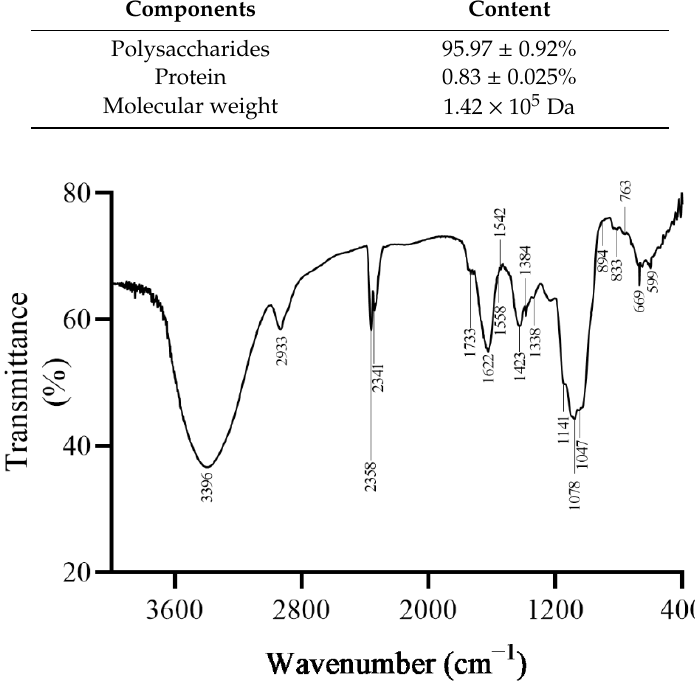
Figure 3. The FT-IR scanning spectrum of PBE.